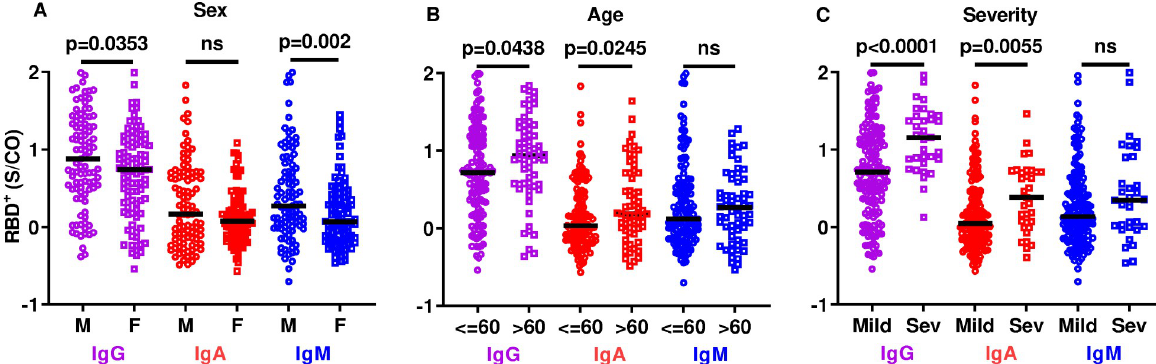
Fig 2. SARS-CoV-2 RBD + antibody levels at V1 by sex, age, and disease severity. Scatter plots of RBD + IgG/A/M levels in COVID-19 recovered patients at V1, by sex (A), age (B), and COVID-19 severity (C). Values on the y-axis are presented as the ratio between the signal obtained to the mean signal for the negative controls (cutoff) in each microwell plate (S/CO). Mean values are indicated by solid black lines. P values were determined using an unpaired, two-sided Mann-Whitney U-test; p < 0.05 was considered statistically significant. M—male; F—female; Mild— mild symptoms during the active phase of the disease; Sev—severe symptoms during the active phase of the disease.